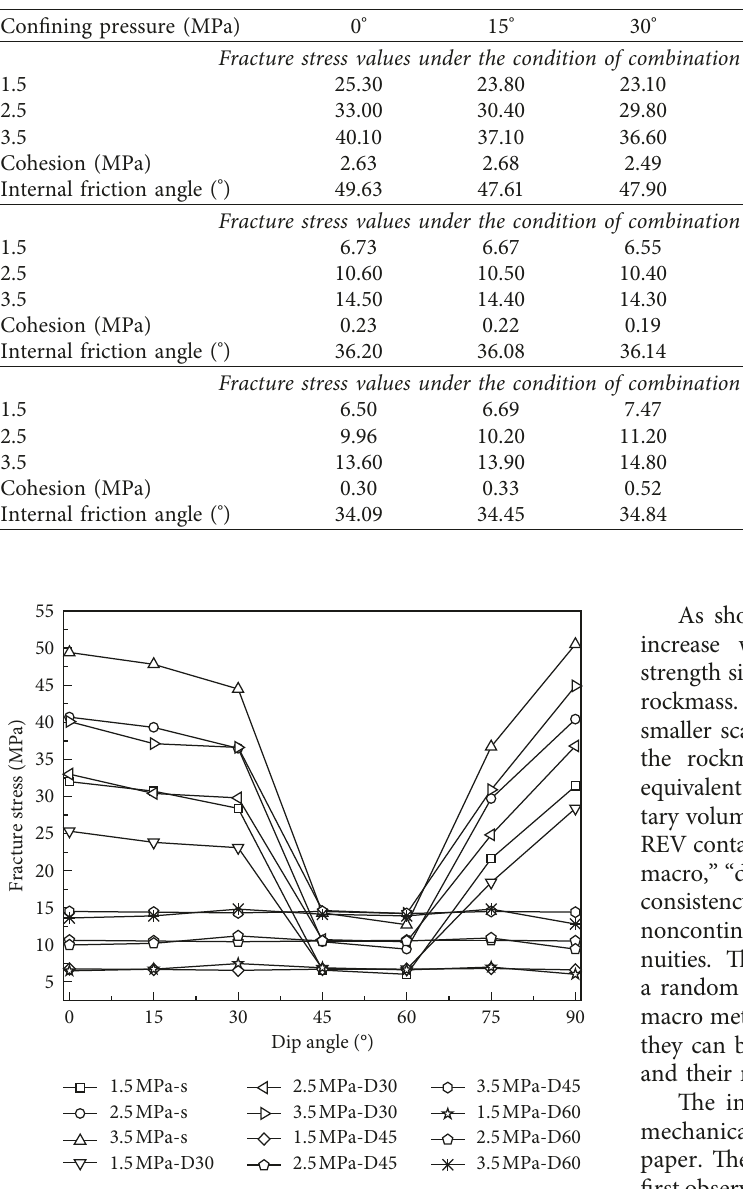
Figure 4: Fracture stress values of X-shaped structure plane rock- mass under the dip angle with different combination ( s represents single structure plane, and D represents double structure